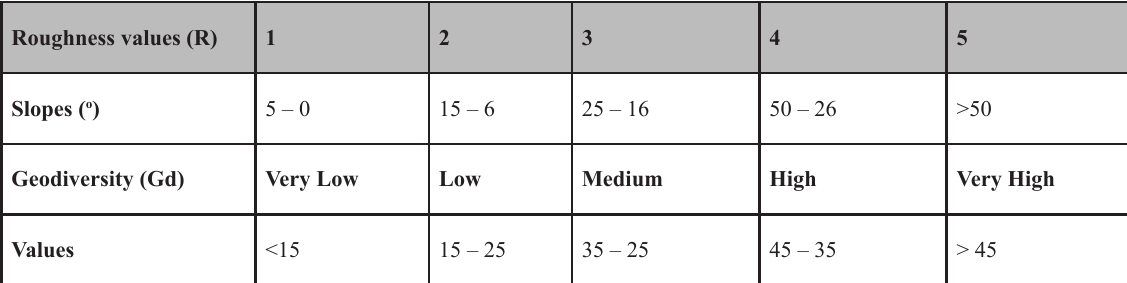
Table 2. Designation of specific roughness values based on dominant slopes and categorisation of geodiversity based on the